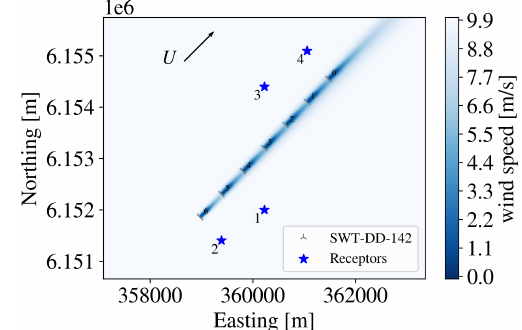
Figure 12. The flow field at hub height through the row of seven SWT-DD-142 wind turbines at the wind direction θ = 225 ◦ . The distances between the turbines are scaled to be approximately 4.3 D